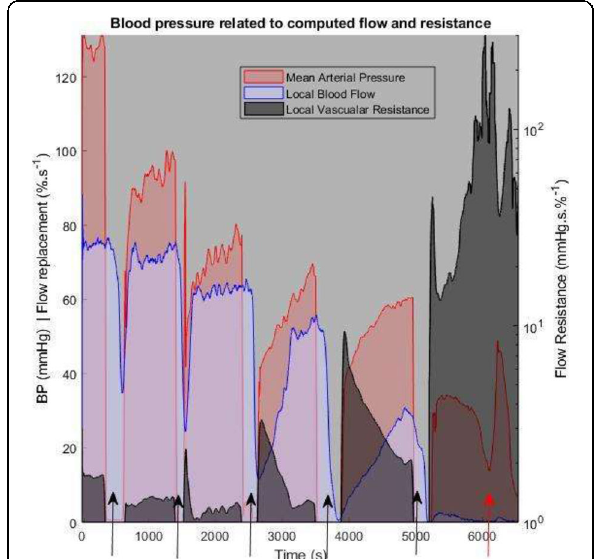
Fig. 1 (abstract 0334). Serial haemorrhage: non-survivor. 10% EBV drawn at black arrows. Blood returned at red